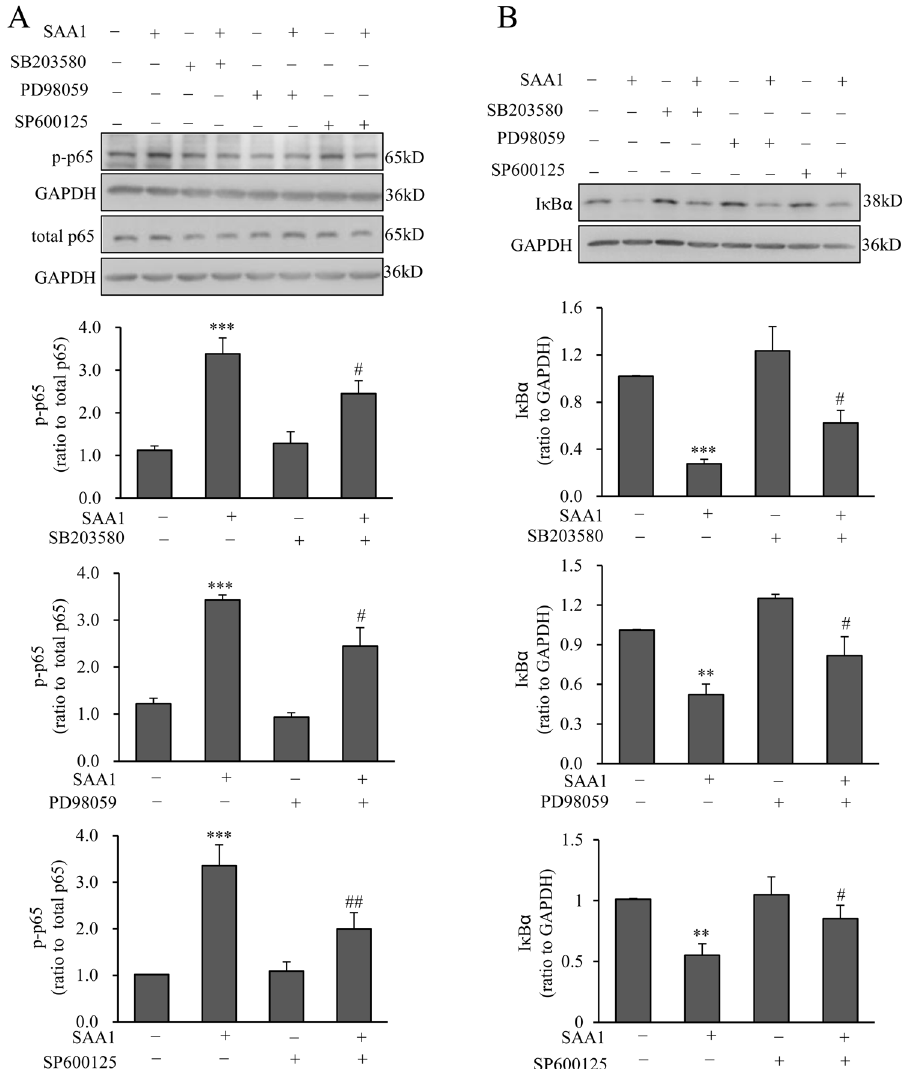
PD98059 (20 µ M) and JNK inhibitor SP600125 (20 µ M) on SAA1 (10 ng/mL, 1 hour)-induced increase in p65 phosphorylation ( A ) and decrease in I κ B α abundance ( B ) in human amnion fibroblasts. n = 5. Top panels are the representative immunoblots. Data are the means ± SEM. Statistical analysis was performed with